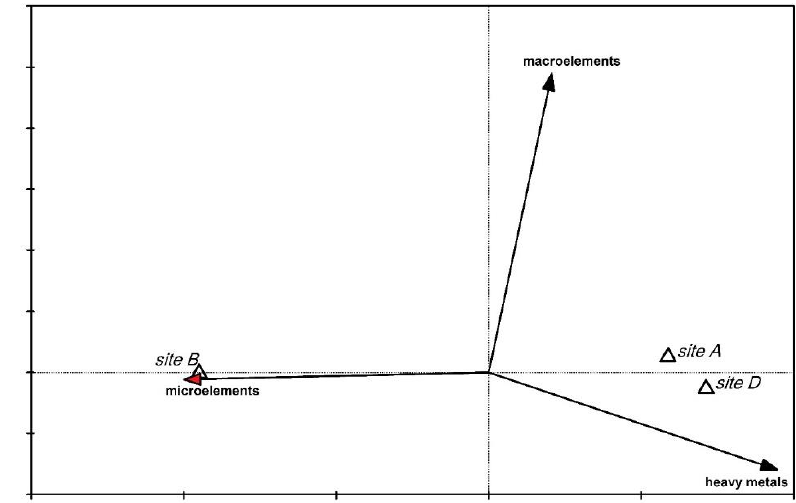
Figure 8. Canonical Variate Analysis (CVA) for Ulva elemental composition from study sites with the chemical groups of elements. The sites were marked with triangles and the elemental chemical groups were marked with vectors. The red tip of the vector signifies a statistically significant variable and 50% of the variance of the data.